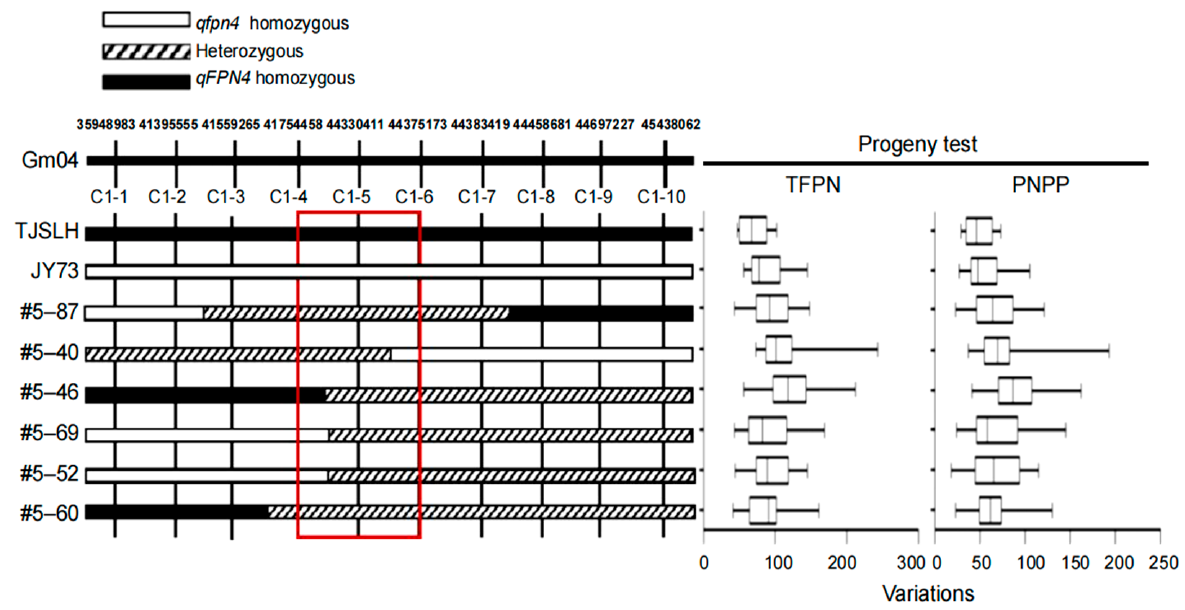
Figure 3. Fine mapping of qFPN4 . Graphical genotypes of soybean recombinants carrying crossovers at qFPN4 . The white bars represent the homozygote for the qFPN4 allele from TJSLH, the black solid bars represent the homozygote for the qfpn4 allele from JY73, and the crosshatched bars represent the heterozygote. All the recombinants were derived from RHL family #5. Six recombinants were genotyped with ten newly developed Indels. Physical coordinates of the markers were obtained from the soybean reference genome and indicated at the top of the markers. TFPN and PNPP for the recombinants were evaluated for at least 30 of their respective progeny and shown in the right panels.